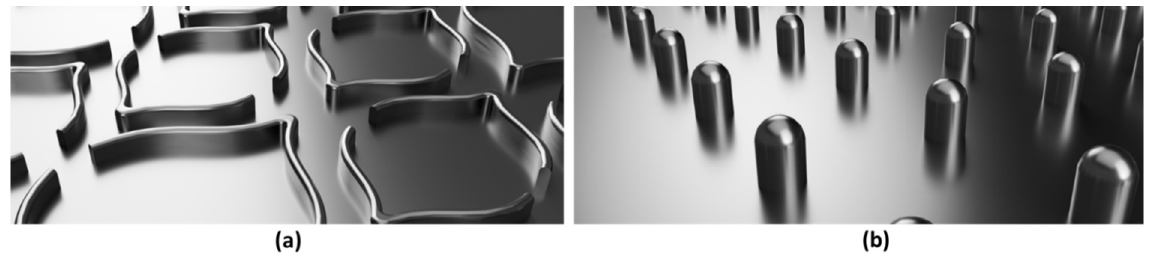
Figure 4. Embossing patterns: ( a ) deco embossing, and ( b ) micro embossing.